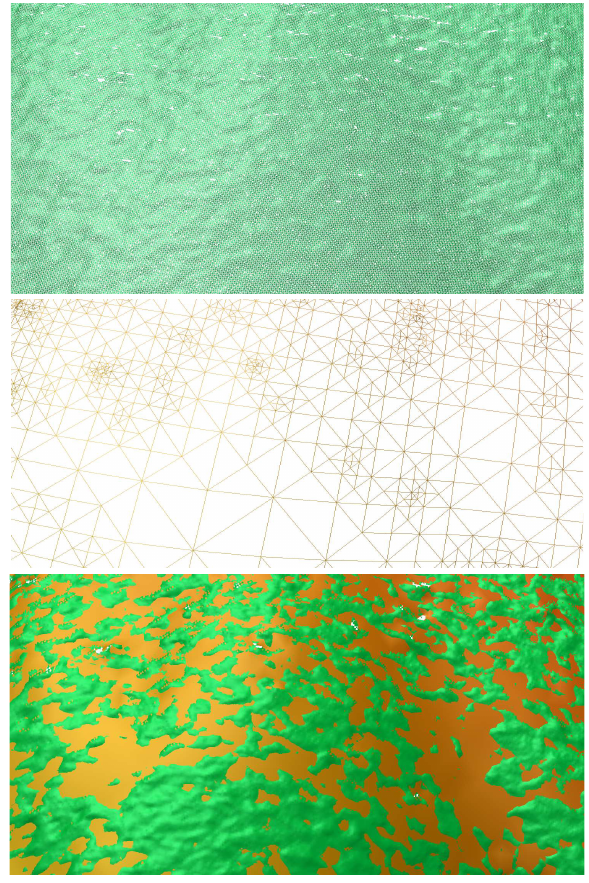
Figure 3: Meshes generated by quadtree approach in dependence of ǫ . Upper: Uncompressed triangulation for ǫ = 0 . Middle: RQT triangulation with ǫ = 1 . 2 . Lower: Overlay of shaded sur- faces ǫ = 0 (green) and ǫ = 1 . 2